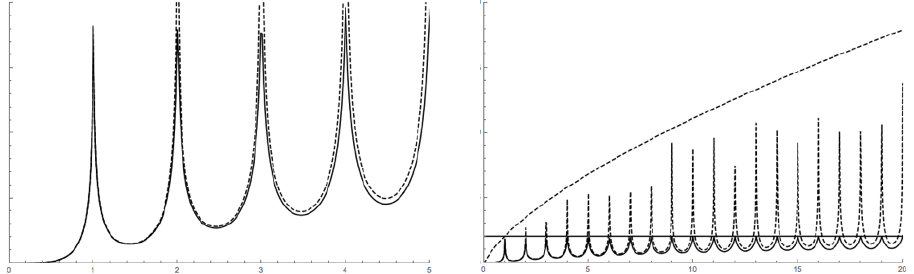
Figure 17. Particle production (270) in terms of the number of crossings of zero, j = Mt accounts for the expansion of the universe, with a ( t ) = t 2 3 , which can be neglected in the first few oscillations. The production of particles is resonant in the points where the Higgs crosses zero ( left ). If the expansion of the background spacetime is neglected, the production of particles in the peaks rapidly tends to a constant value. However, when the expansion is taken into account, the number of particles in the peaks scale with the scale factor ( right